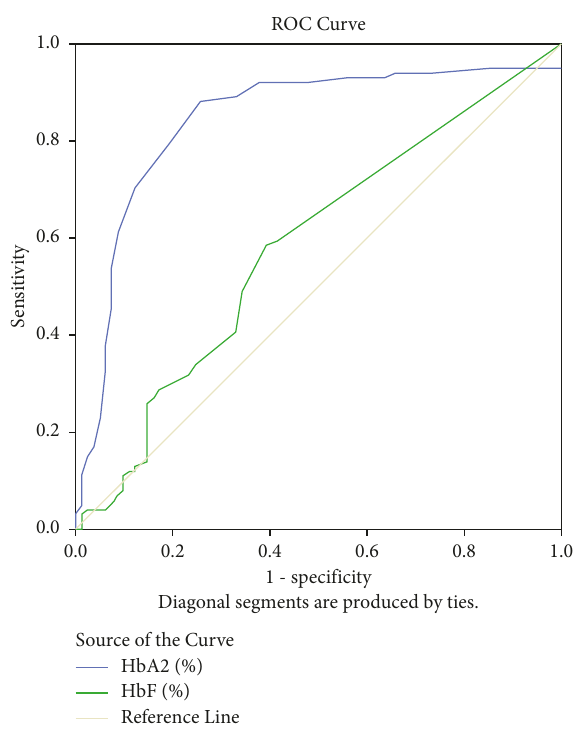
Figure 2: Receiver operative characteristic curves (ROC) of HbA ( P 0 . 001) and HbF ( P <